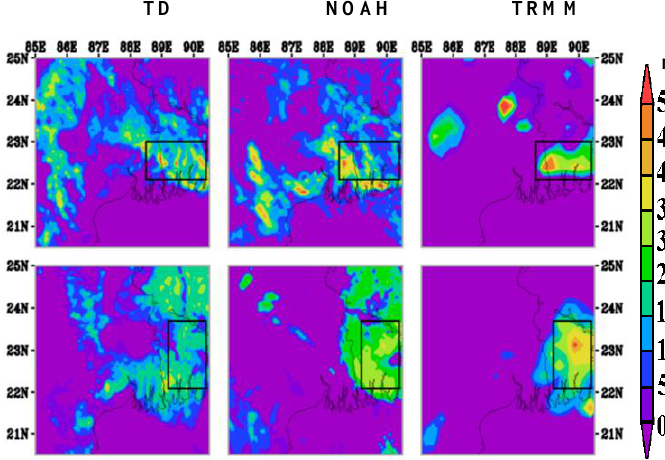
Fig-3: six-hourly accumulated rainfall (mm) along with TRMM observed rainfall during severe thunderstorm event for (a) case-1 (12UTC-18UTC), (b) case-2 (6UTC-12UTC), (c) case-3 (0UTC- 6UTC) and (d) case-4